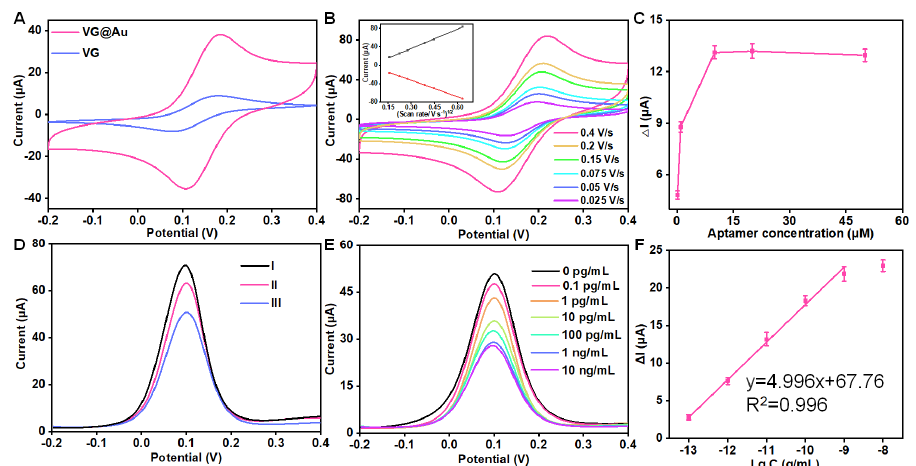
Figure 3. The analytical performance of the portable VG@Au-based electrochemical aptasensing platform for point-of-care detection of tau protein. ( A ) A electro-active area comparison (CVs) of VG and VG@Au electrode in 5 mM (Fe(CN) 6 ) 3 − /(Fe(CN) 6 ) 4 − solution containing 0.1 M KCl at 0.01 V/s. ( B ) CVs of VG@Au electrode at different scan rates. The inset is the relationship between peak current and the square root of scan rate. ( C )The optimization of DNA aptamer. ( D ) DPV signals of VG@Au (line I), VG@Au + aptamer (line II), VG@Au + aptamer + MCH (line III). ( E ) DPV signals of different concentration tau protein in 5 mM (Fe(CN) 6 ) 3 − /(Fe(CN) 6 ) 4 − solution containing 0.1 M KCl at 0.01 V/s. ( F ) The corresponding calibration curve of figure ( E ).